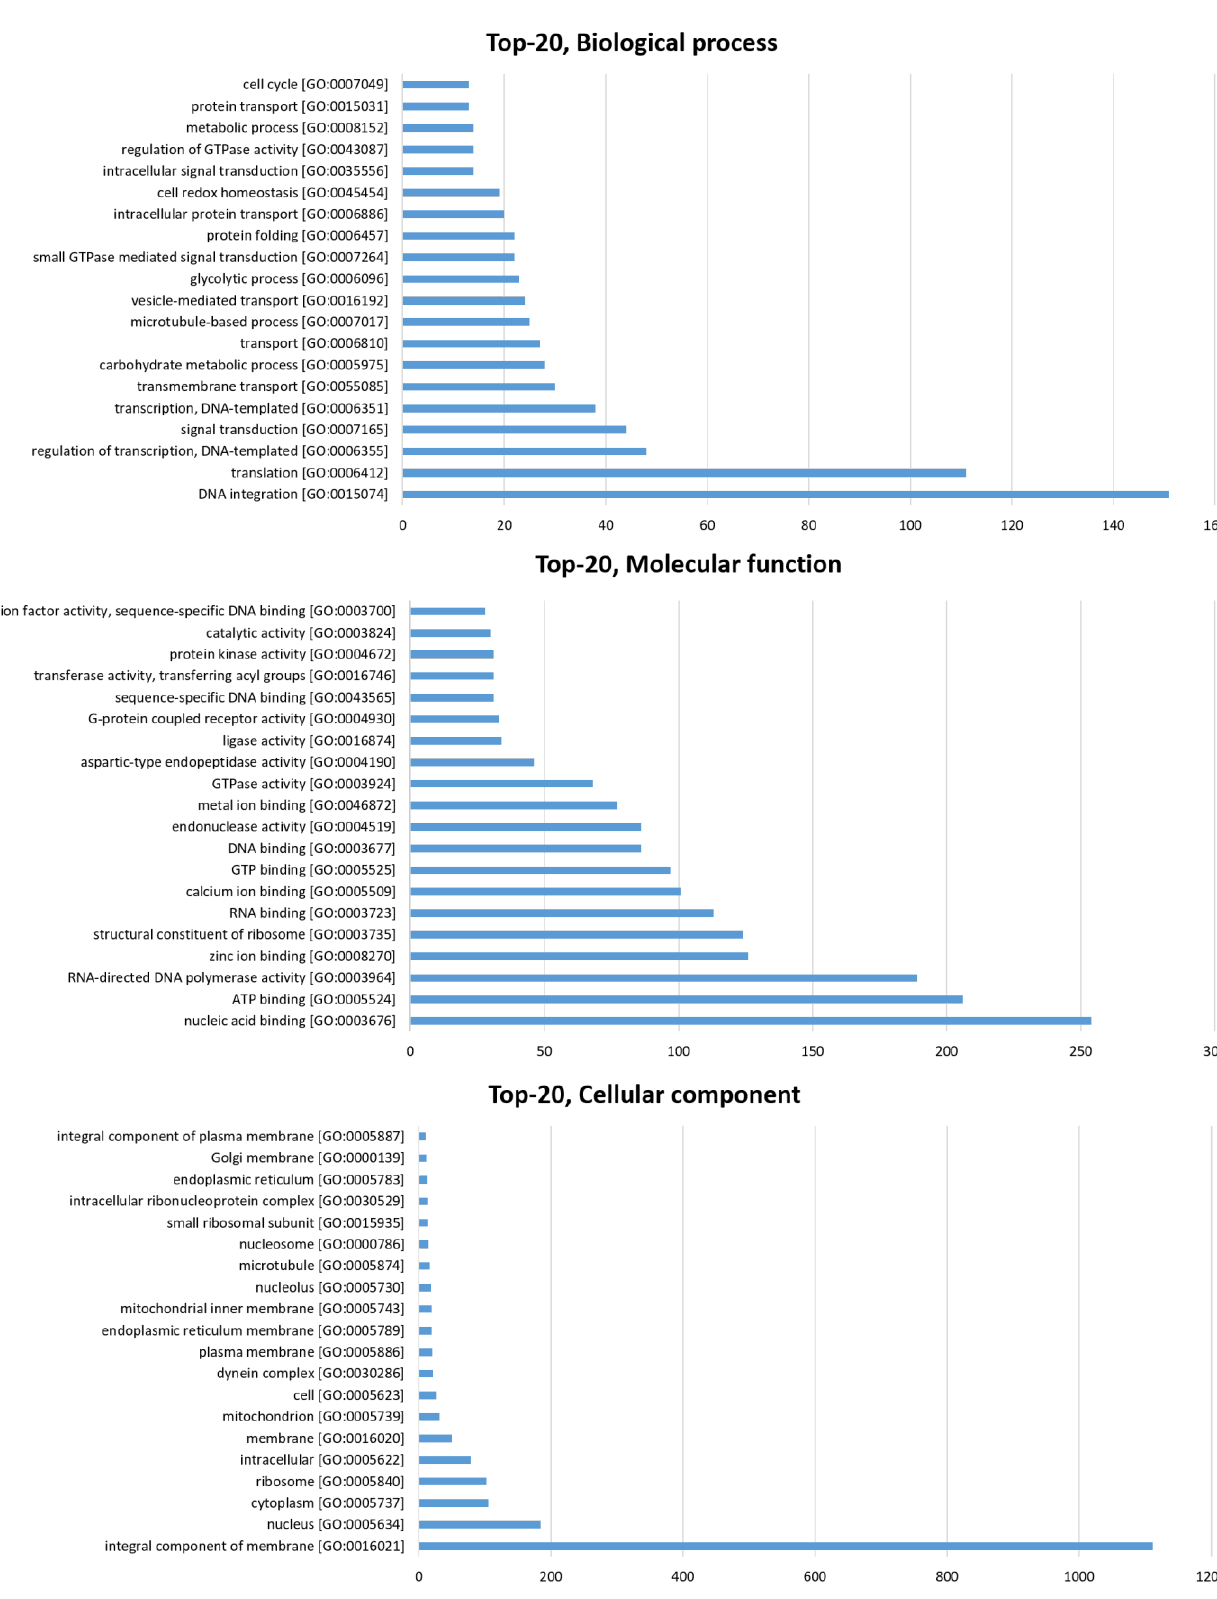
Figure 3. Top - 10 most significant gene ontology classification of S . mekongi peptidome identified by mining approach.